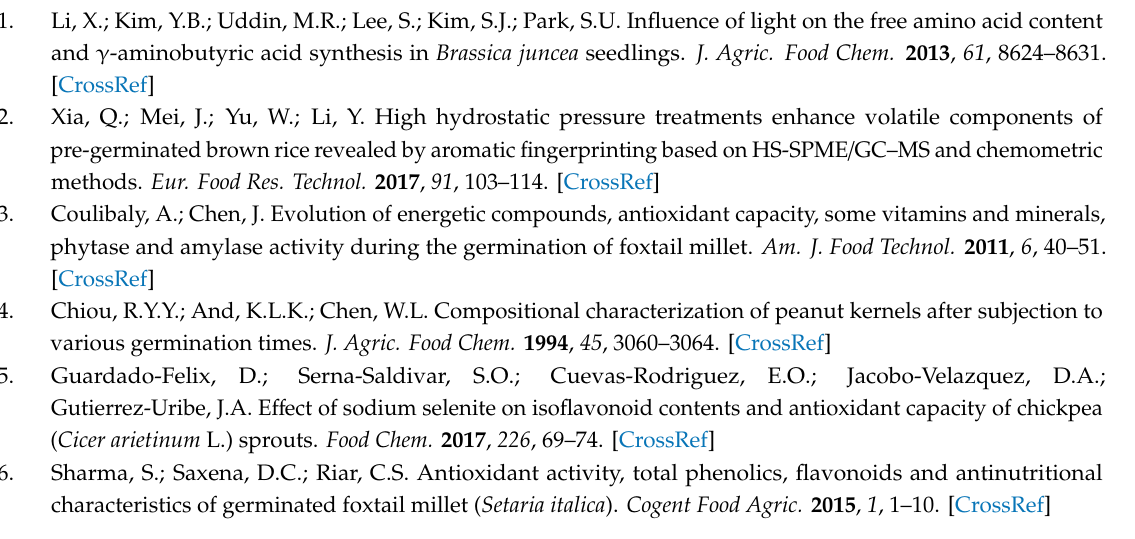
Supplementary Materials: The following are available online, Figure S1: Variation pattern of the lipase activity during foxtail millet germination. Figure S2: Volatiles are produced by the autoxidation of palmitoleic acid, linoleic acid, and oleic acid. Figure S3: Volatiles are produced by the enzymatic oxidation of palmitic acid and stearic acid. Figure S4: 3-Methyl-butanol and 2,3-Butanediol are not produced by the enzymatic oxidation of the palmitoleic acid, oleic acid, linoleic acid, and linolenic acid. Table S1: Calibration curves for quantification of the fatty